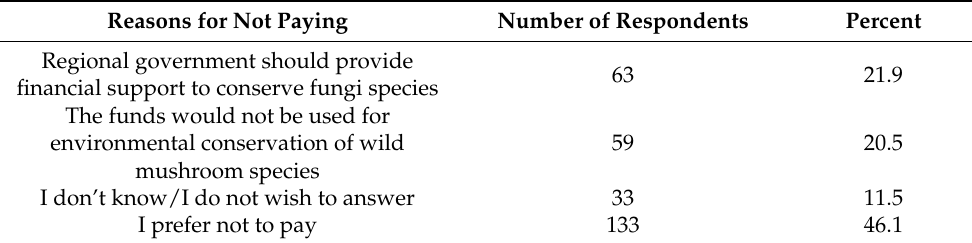
Table 2. Respondents’ reasons for not paying.